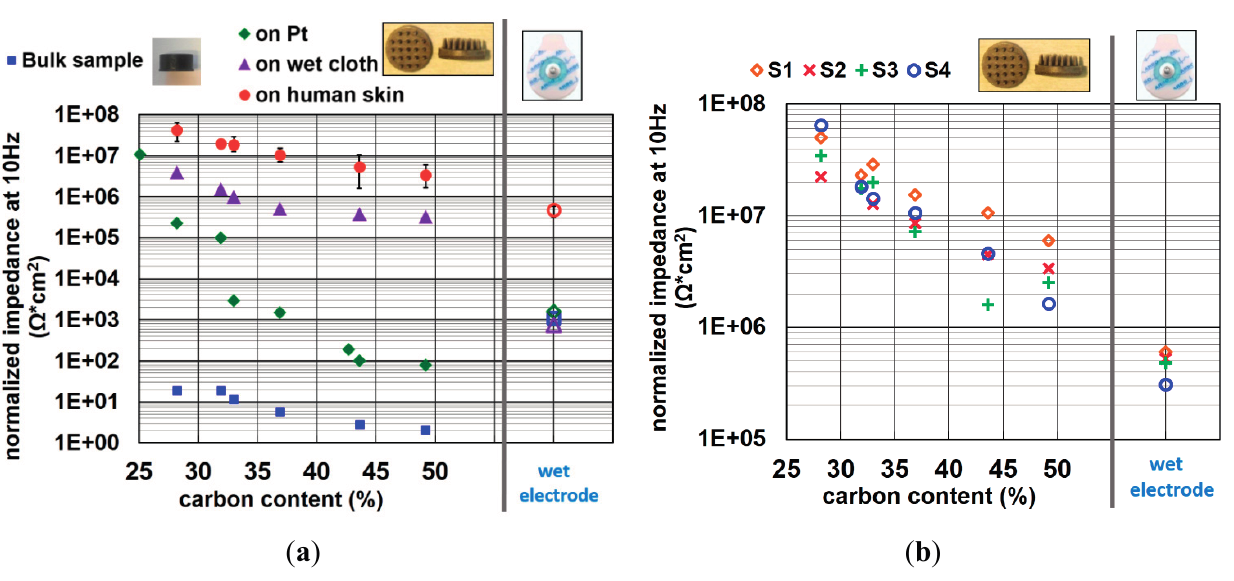
Figure 6. Normalized impedance at 10 Hz signal frequency of conductive polymer electrodes with various carbon content ( a ) of materials themselves, on phantoms and on human skin; ( b ) on forearm skin of four different subjects